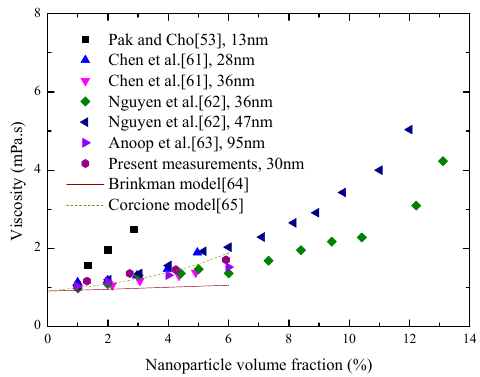
Figure 11. Variations of Al 2 O 3 -water nanofluids’ viscosity with nanoparticle volume fraction at room temperature [53,61–65].